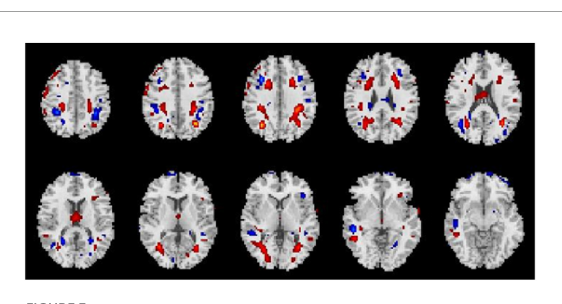
FIGURE3 Comparison of gFCDs before versus after 24-week treatment with only lithium (Li